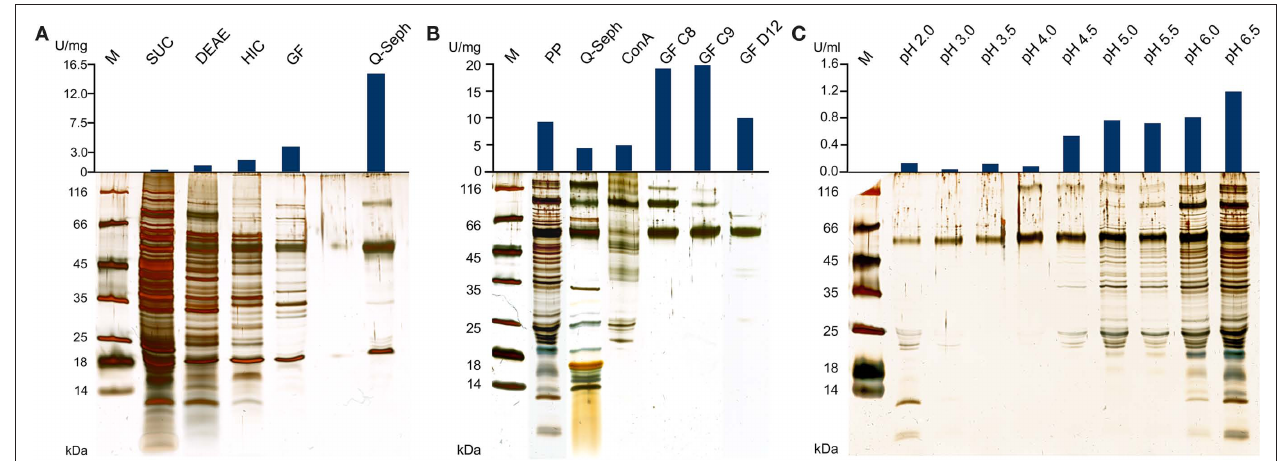
FiguRe 1 | Silver-stained SDS gels and activities of TTH fractions from A. ambivalens . (A) Purification of the TTH from soluble cell extracts and specific activities; SUC, supernatant ultracentrifugation; DEAE and HIC, active fractions of DEAE anion exchange and hydrophobic interaction chromatographies, respectively; GF, size exclusion chromatography; Q-seph, Q-sepharose chromatography. (B) Purification of the TTH from the pseudo-periplasmic fraction [obtained by incubation in buffer pH 6.5; see (C) ] and specific activities; PP, pseudo-periplasmic fraction; Q-seph, Q-sepharose chromatography; Con